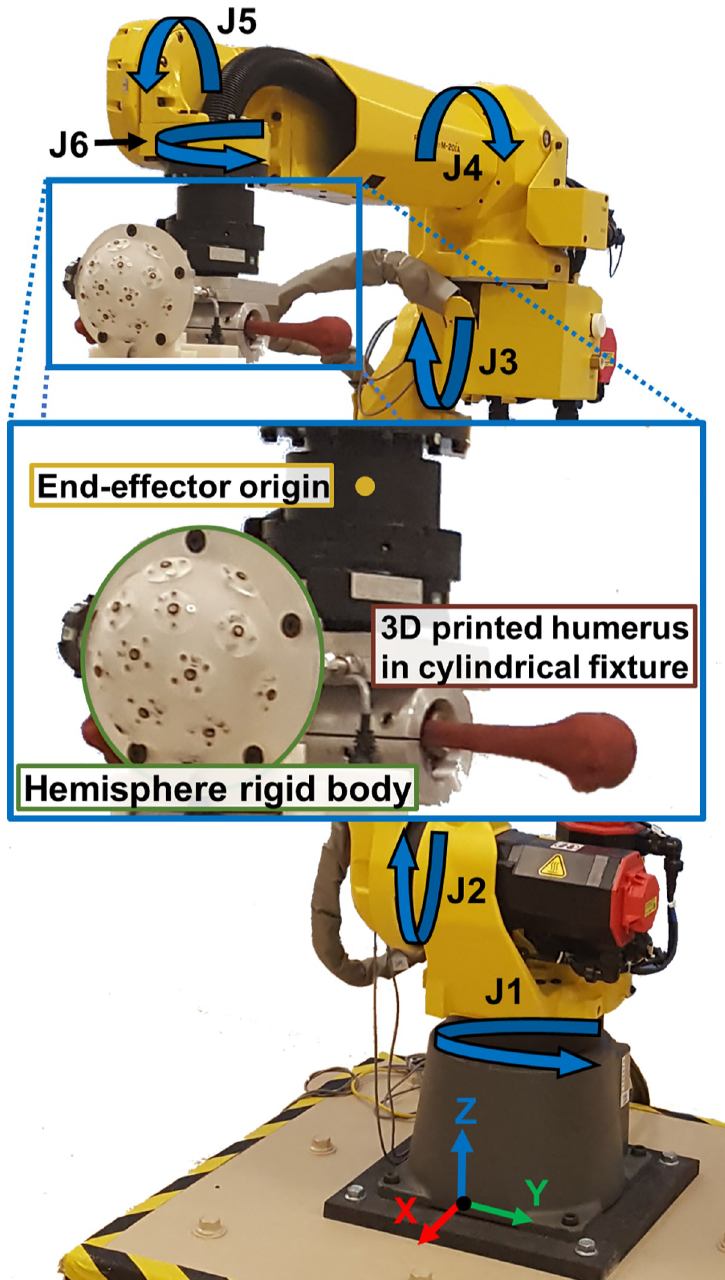
Fig 3. A 6 degree-of-freedom robot with optical tracking hemisphere rigid body and 3D printed humerus. The rotational motion of the robot’s joints (J1-J6) is indicated by the blue arrows, and the Cartesian coordinate system of the robot is shown at its